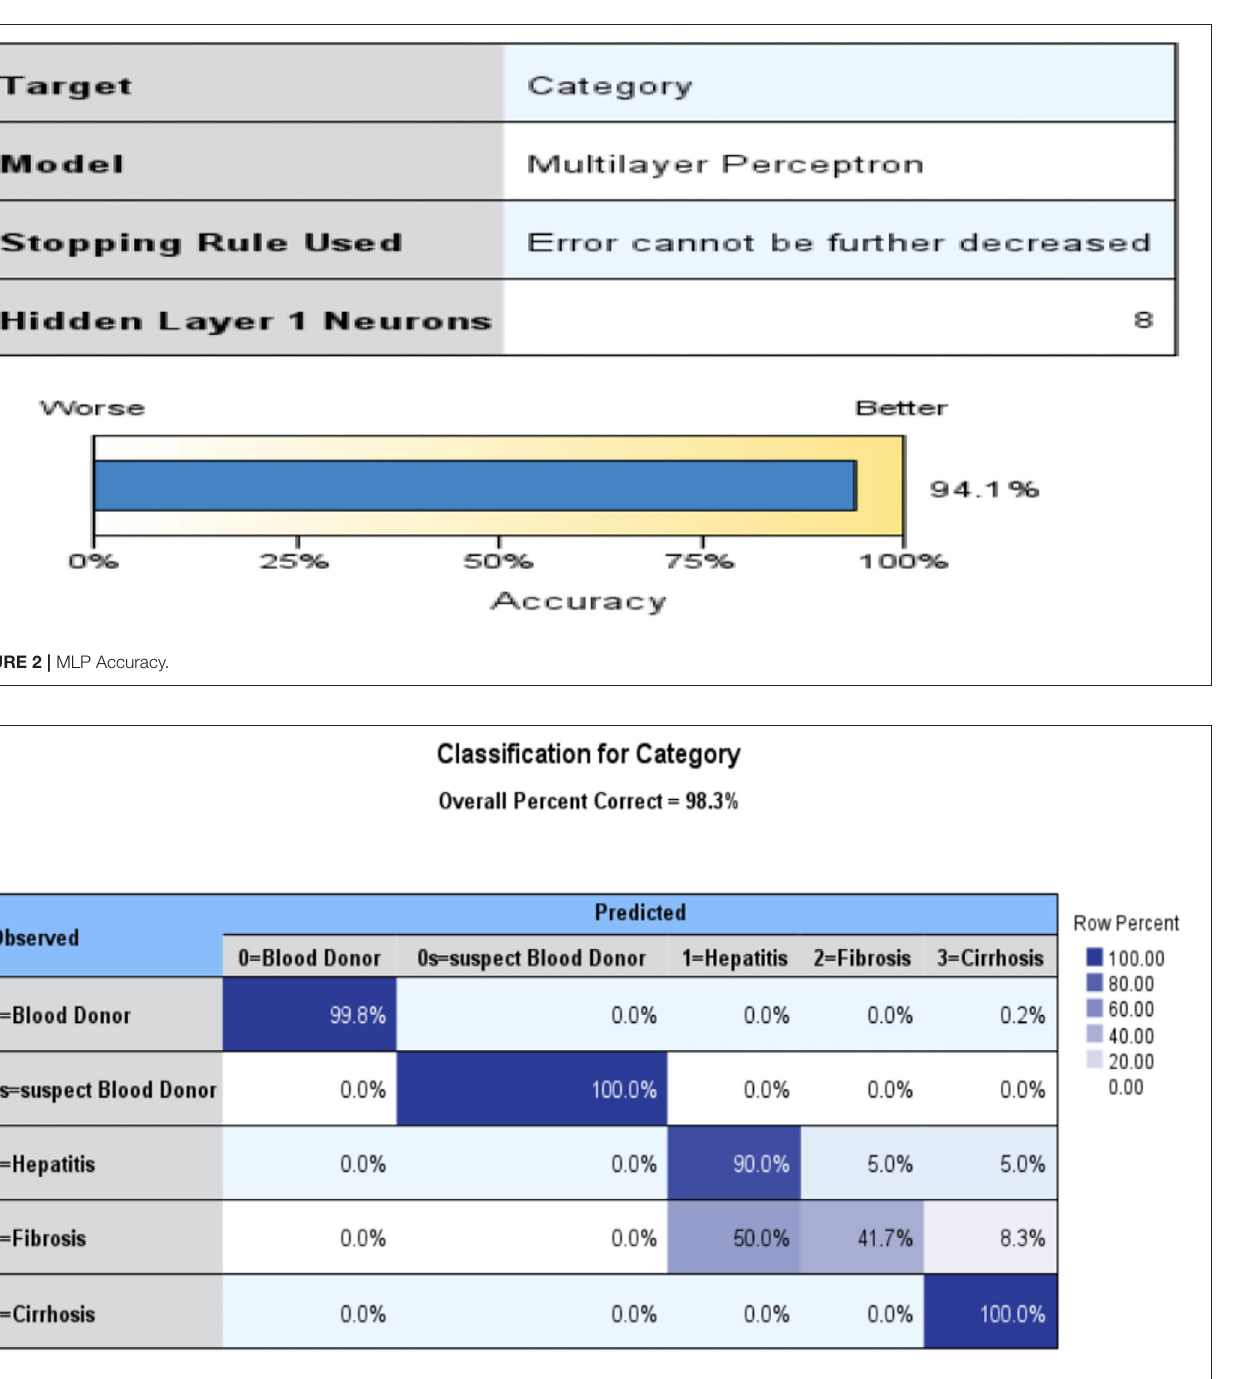
FIGURE 3 | MLP Classification for